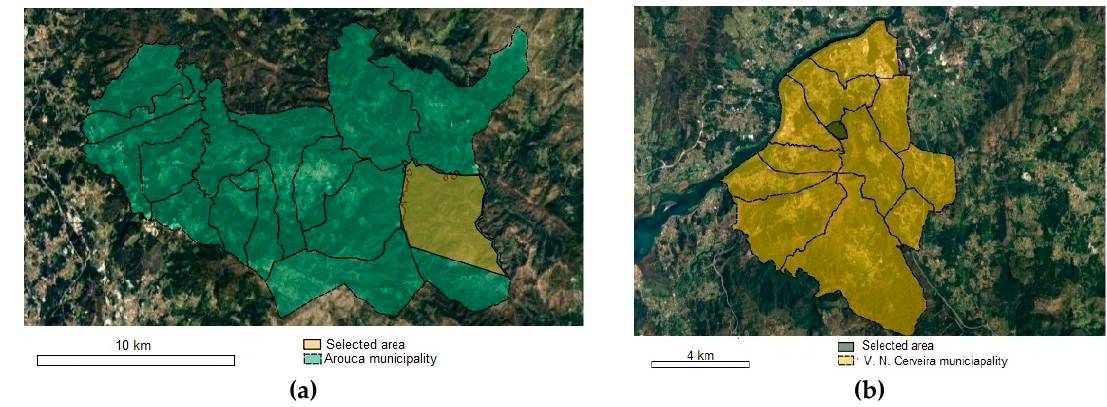
Figure 5. Areas selected for postfire analysis in ( a ) Arouca (yellow) and ( b ) V.N Cerveira (green) municipalities.